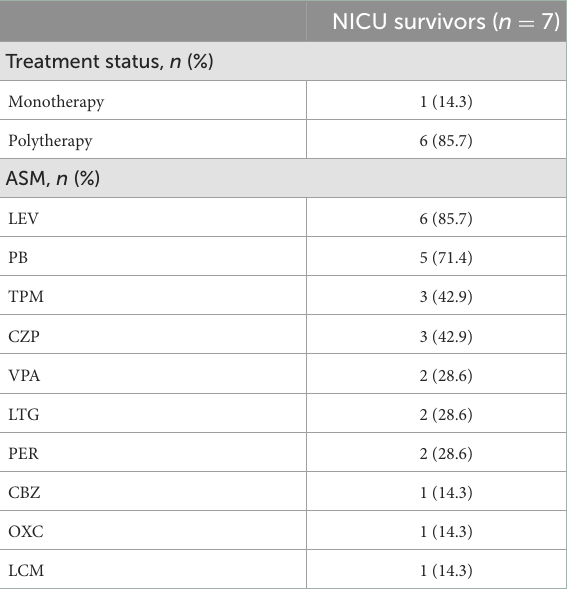
TABLE 2 ASM status of NICU survivors at the end of